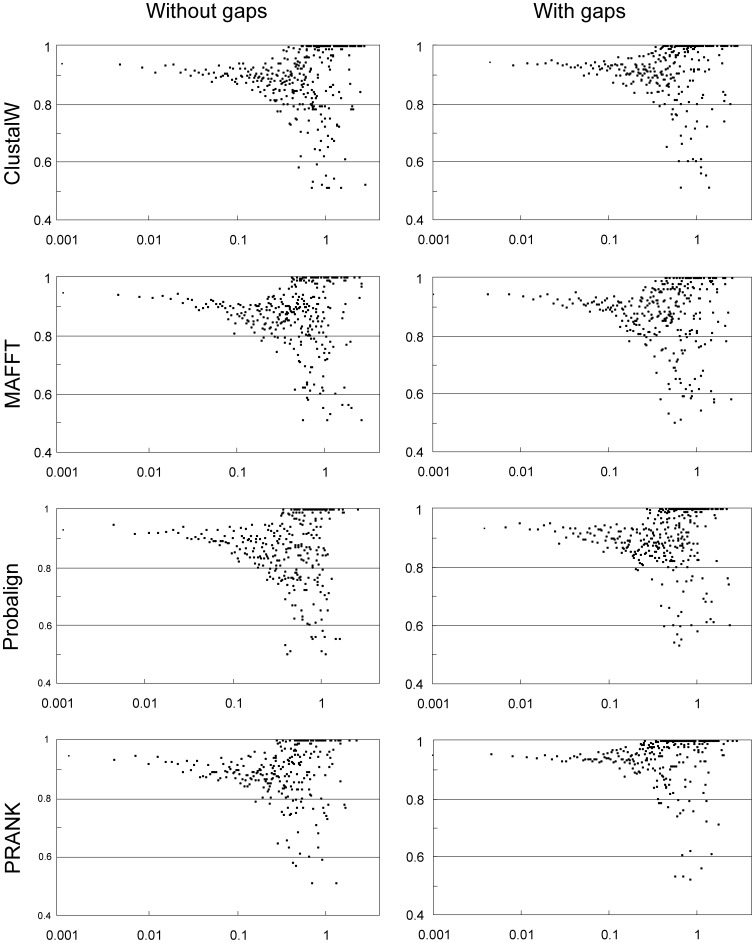
The phylogenetic utility of the ITS region as a function of evolutionary divergence.To test whether indel data extends the resolution power of the ITS locus above the species level (i.e. above intrageneric comparisons), we depicted node resolvability as a function of node depth, calculated as the mean of the path lengths between the node of interest and its descendant leaves on each consensus tree. The range of node-depth values was divided to 800 discrete categories (200 and 400 categories produced the same distributions). Depicted are the means of the Bayesian posterior probabilities of the nodes falling in a specific depth-category (drawn on log scale). Lower values towards higher node-depths signify the decay of phylogenetic signal in the alignments at earlier evolution events. However, it is evident that the addition of indel data decelerates the rate of this decay, except for MAFFT-X-INS-I, for which the effect is hardly noticeable. We found that the high number of values at 1.0 point to depth-categories with a single value, contributed by nodes strongly supported under all settings (very distinct lineages, such as outgroups). For comparison, we made a rough estimate between the relationship of taxonomic range and node depths. Node depth values 0.04–0.23 correspond the genera (although the most recent common ancestor of Russula was on average 0.41 from the tips), 0.22–0.55 to families, whereas 0.5–1.33 to orders. The mean path length to the ancestor of the Basidiomycota was (James et al 2006) 2.3 unit.